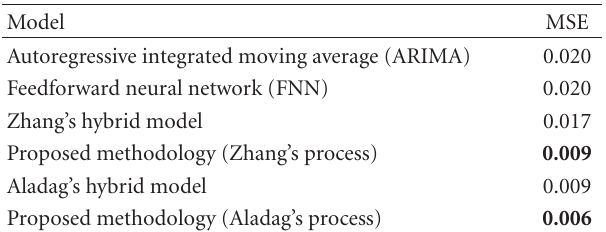
Figure 3: Results obtained from the proposed model for Canadian lynx data set.